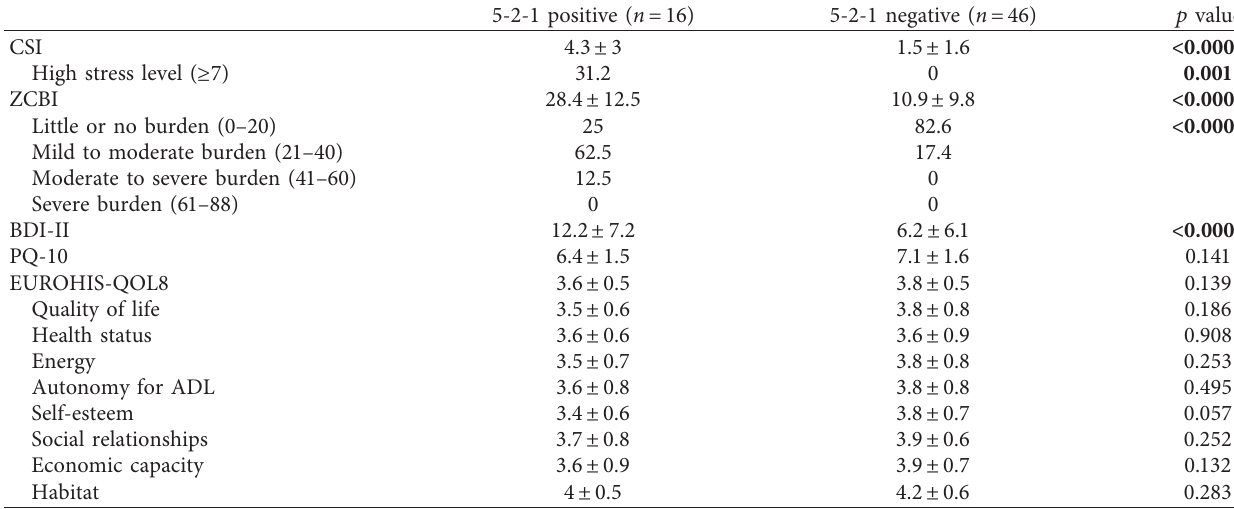
Table 3: Strain, burden, mood, and QoL in patient’s principal caregiver of those patients with 5-2-1 criteria ( n � 16) vs those with 5-2-1 negative criteria ( n �